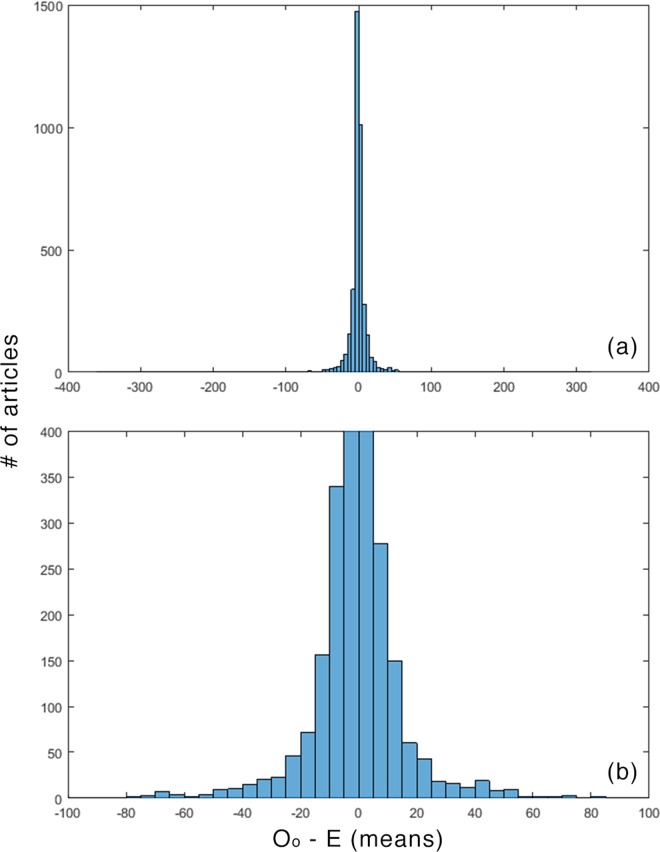
Oo—E for means.(a) overall (b) detail.